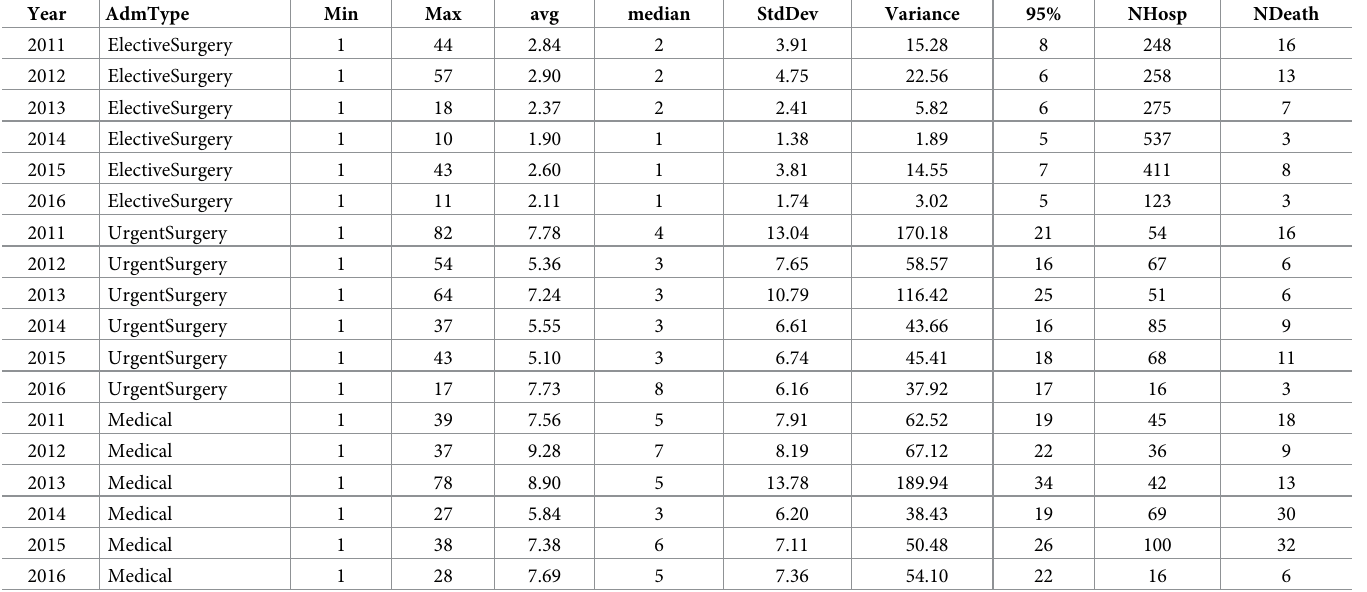
Table 1. Statistics on LoS stratified by year and admission